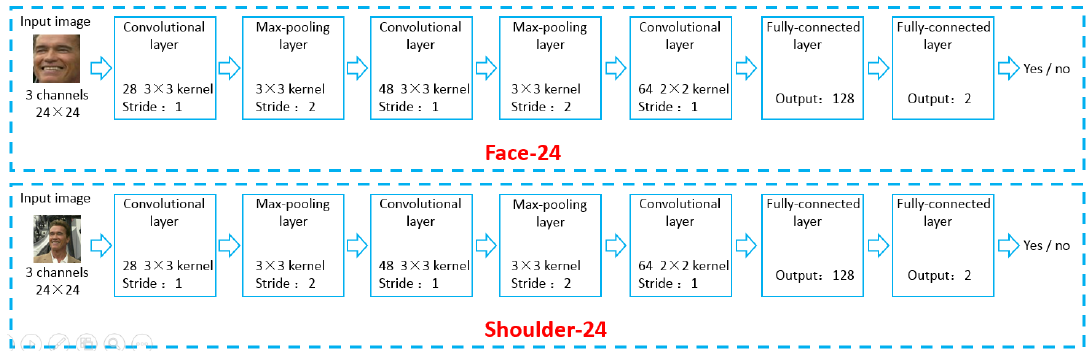
Figure 9. The CNN structure of the two intermediate nets Face-24 and